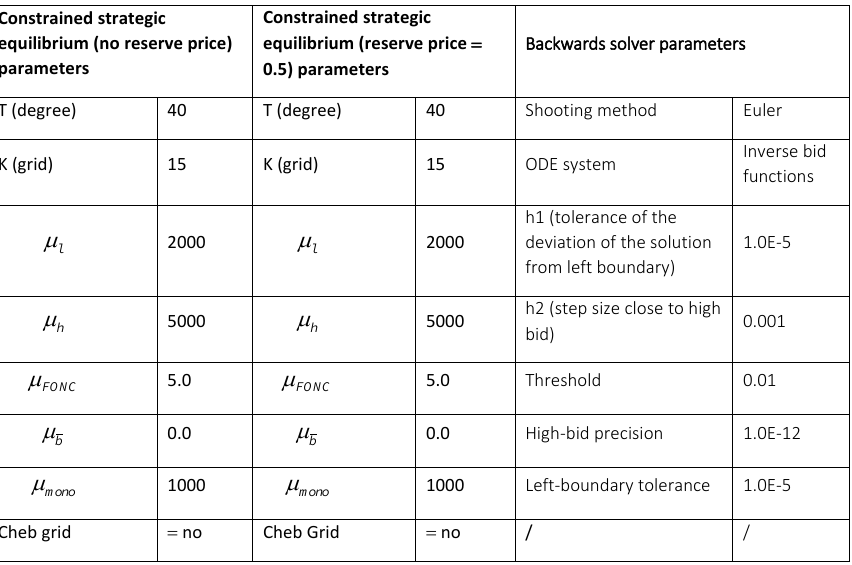
Table 4 C.S.E. and Backward shooting